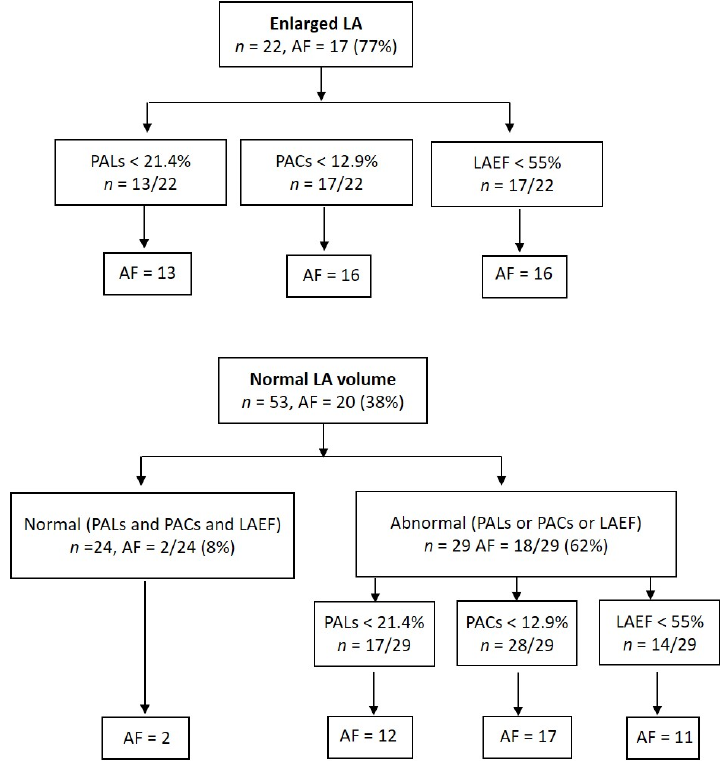
Figure 3. Tree diagram showing results of echocardiographic parameters according to whether left atrium was or was not enlarged.